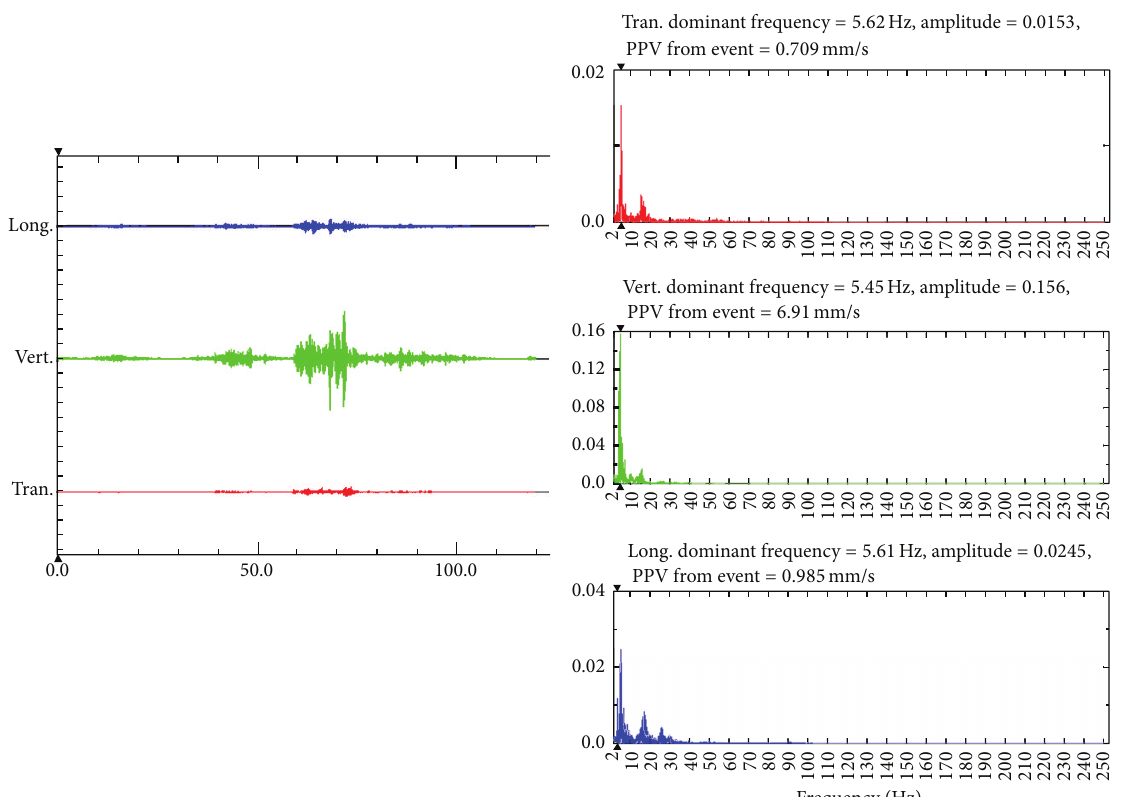
Figure 6: Measurement on moveable station 4R (middle of the